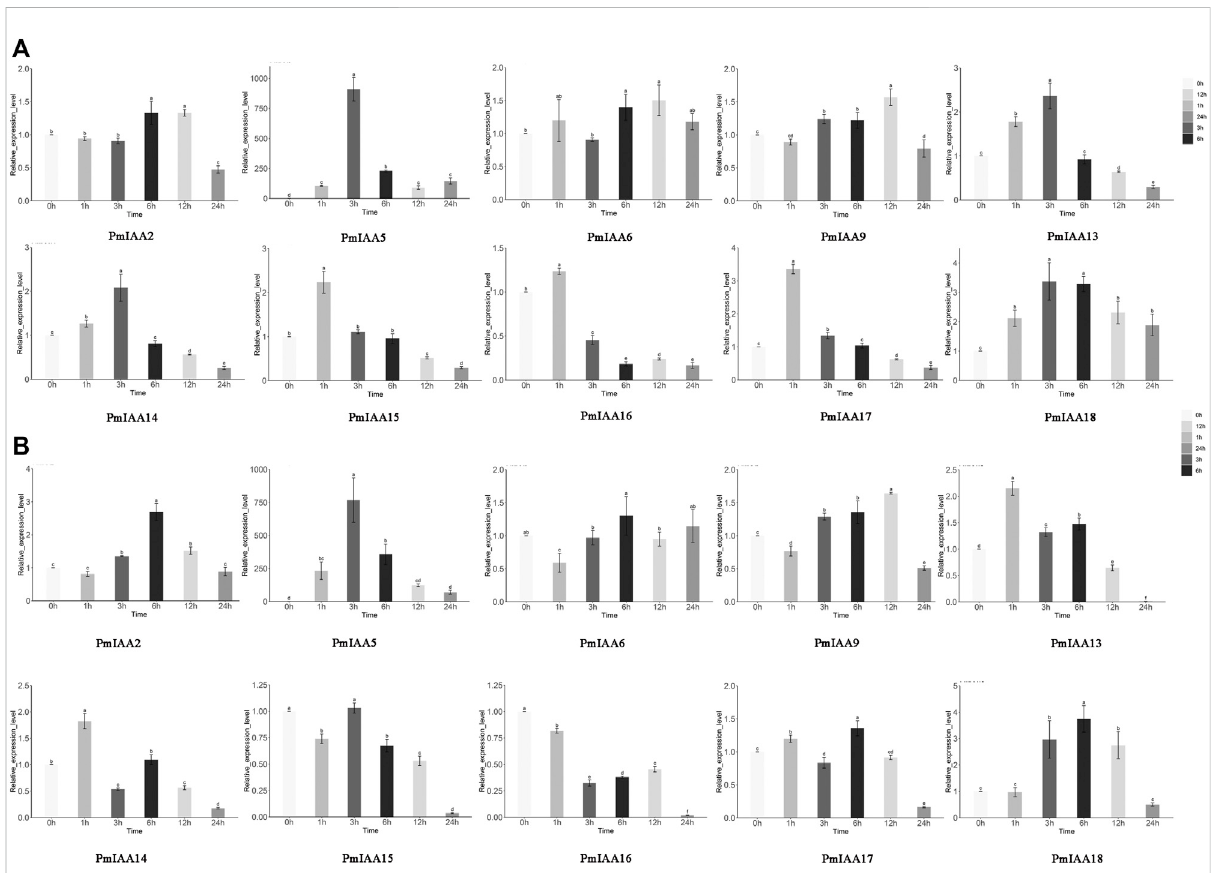
FIGURE 7 Expression pattern analysis of PmIAAs in abiotic stress responses (A) The relative gene expression level of PmIAAs after drought treatment in stems (B) The relative gene expression level of PmIAAs after salt treatment in stems. The mean ± standard error of three replicates is shown. The letters above the error bars are marked with signi fi cance for expression